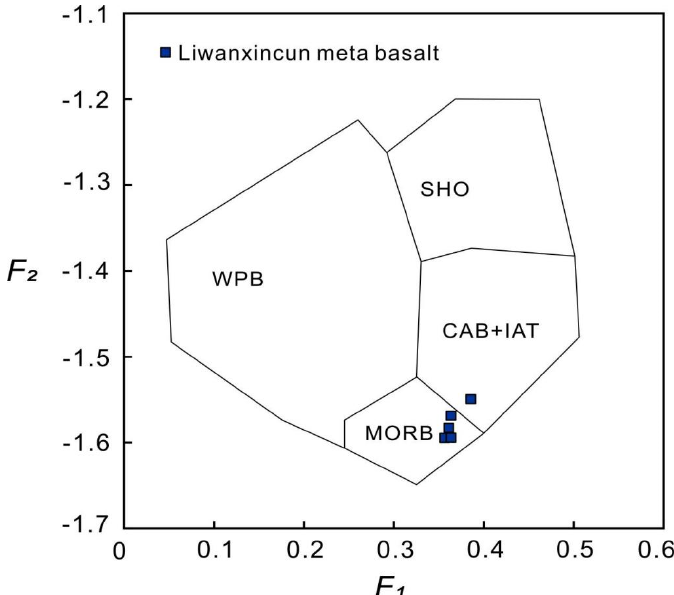
Figure 16. F1–F2 diagram [51] of Liwanxincun metabasalt.